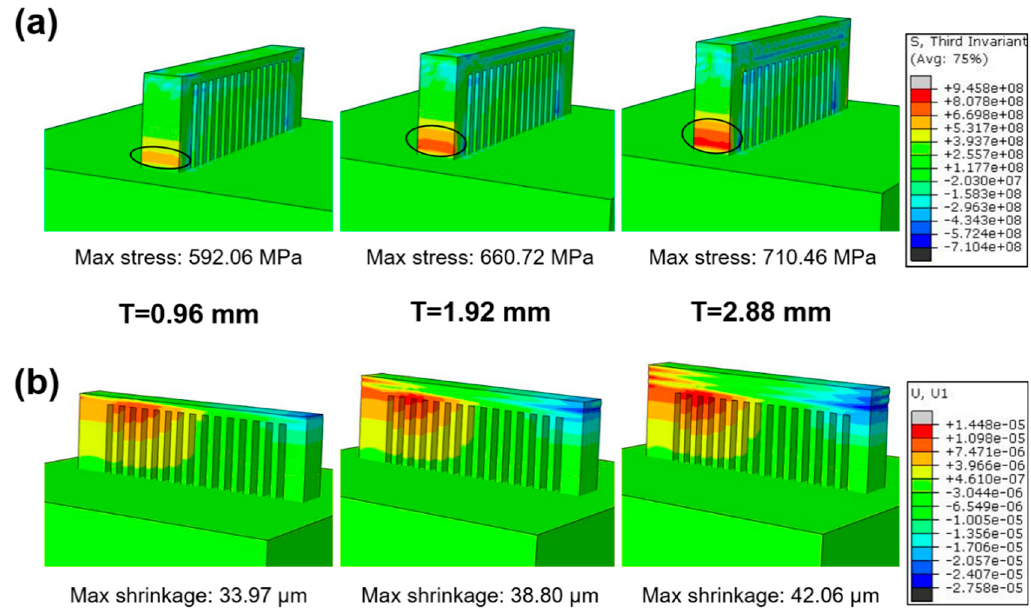
Figure 4. ( a ) Residual stress field and ( b ) longitudinal shrinkage of three typical bar thicknesses under the XY cross scanning